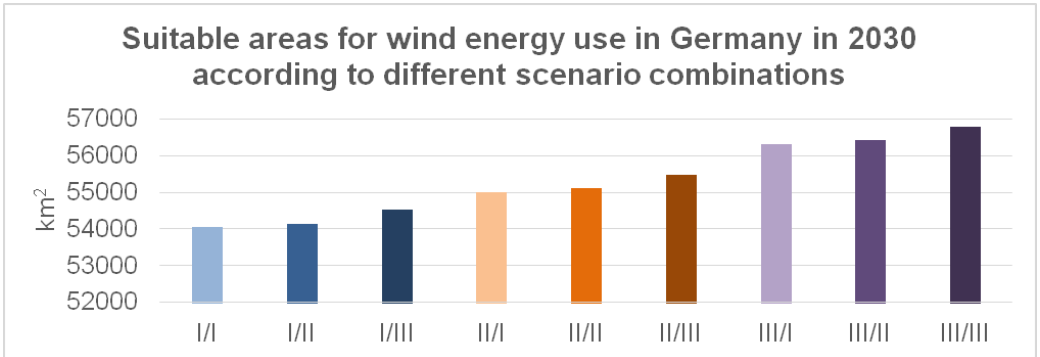
scenario combinations.